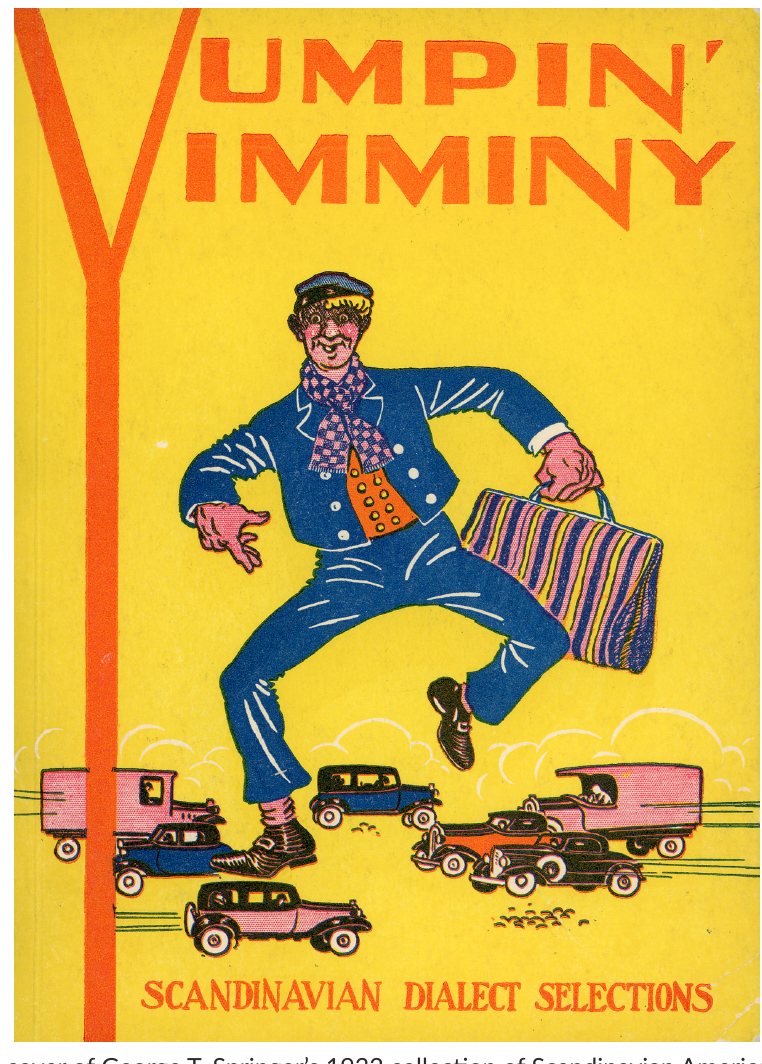
Figure 4: The cover of George T. Springer’s 1932 collection of Scandinavian American dialect humor depicts an immigrant bumpkin in the city. (Author’s